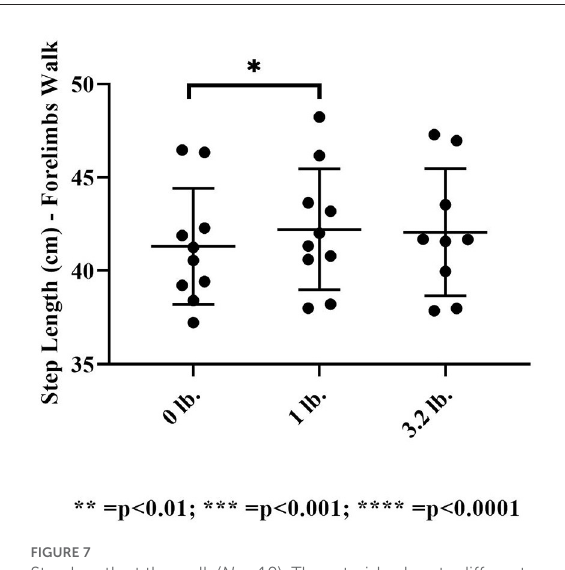
FIGURE7 Step length at the walk ( N = 10). The asterisks denote different levels of significance (* P ≤ 0.05, ** P ≤ 0.01, *** P ≤ 0.001, **** P ≤ 0.0001).